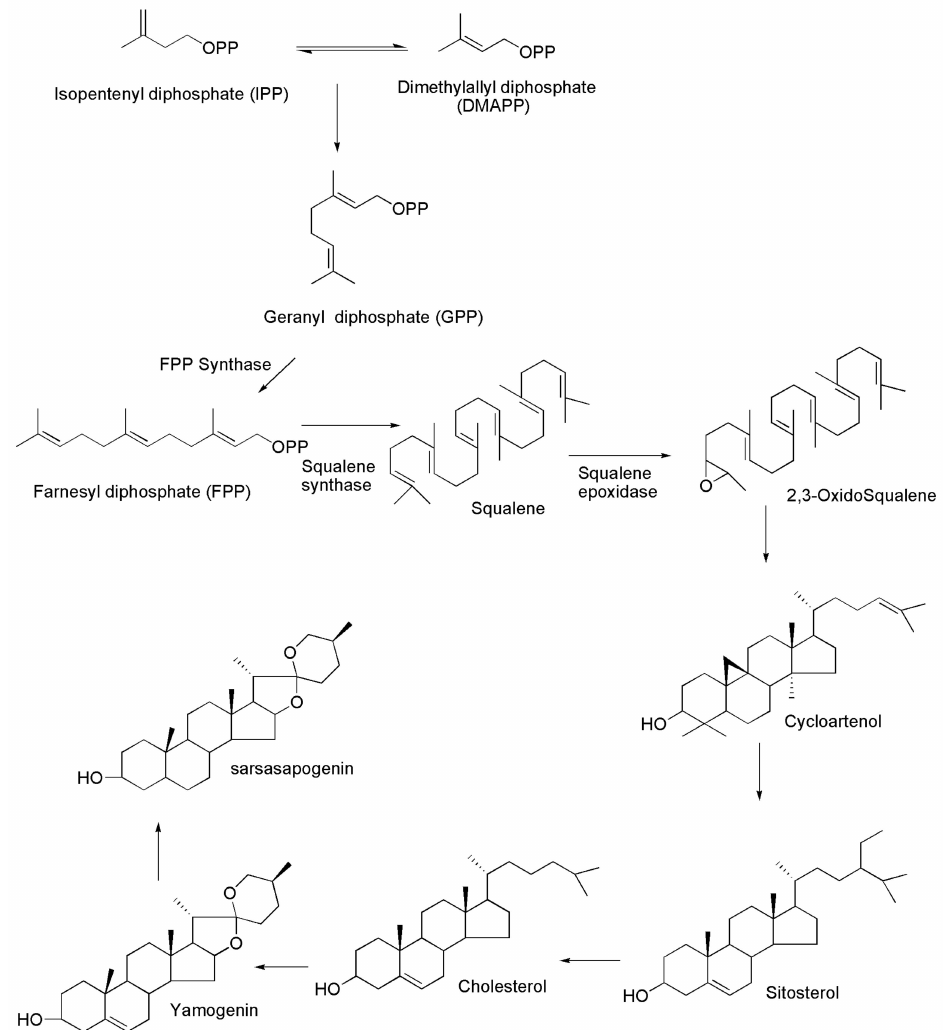
Figure 2. Biosynthesis of